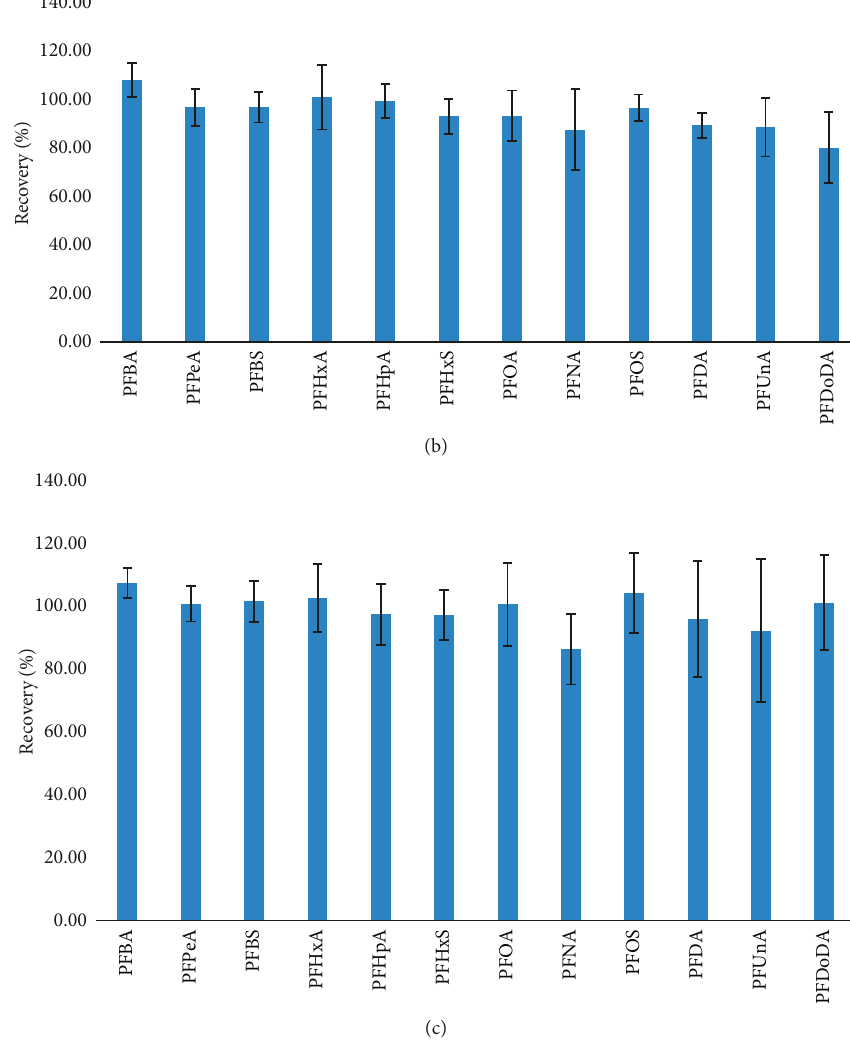
Figure 3: (a) Percentage recovery for all analytes at 10ng · L − 1 . (b). Percentage recovery for all analytes at 25ng · L − 1 . (c). Percentage recovery for all analytes at 50 ng · L − 1 Table 6: Matrix effect index for all analytes. Analyte